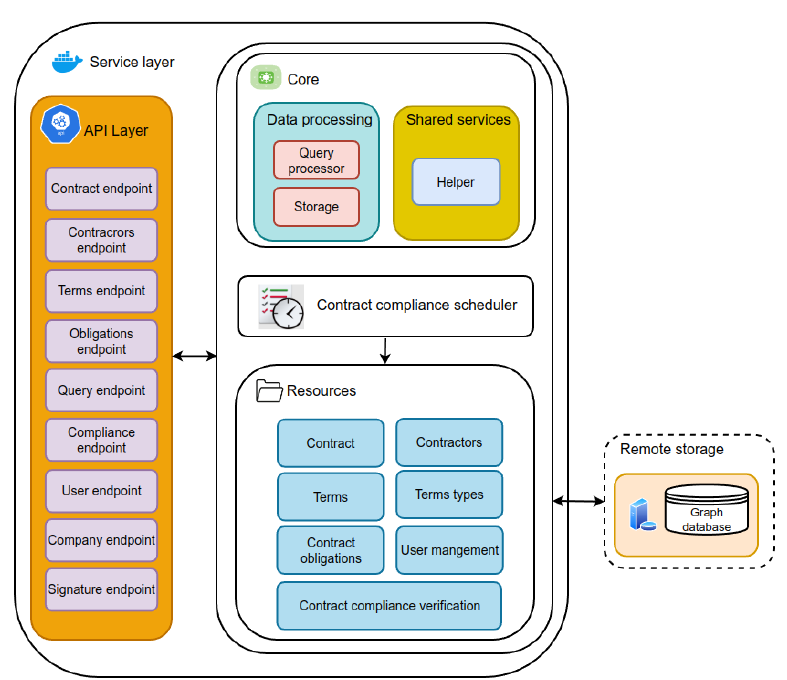
Figure 5. Architectural design of the automated GDPR compliance verification